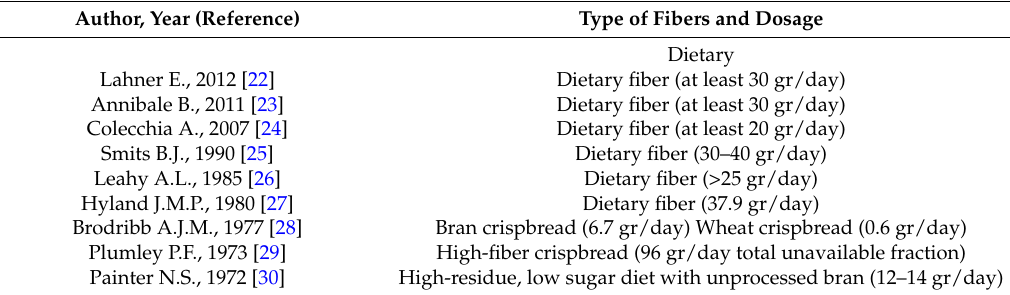
Table 1. Type of fibers and dosage used in the included studies.